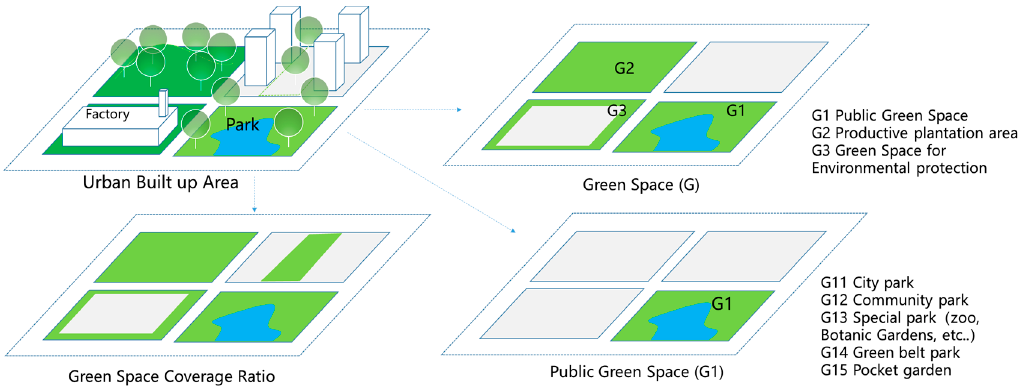
Figure 3. Three kinds of Green Space in Statistics Yearbook of China.